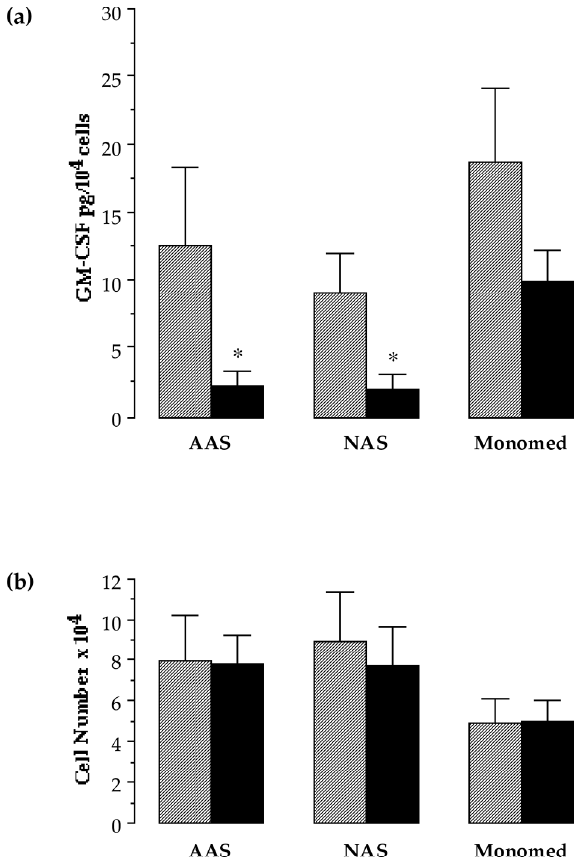
FIG. 1. (a) IL–1 b and TNF- a induced GM-CSF release, and (b) human airway smooth muscle cell (ASMC) density in cultures immediately prior to stimulation with IL–1 b and TNF- a . Confluent human ASMC were pre-incubated with either allergic asthmatic serum (AAS), non-allergic non- asthmatic serum (NAS) or Monomed™ (a defined serum substitute) for 24h. Cells were serum starved for 24h (striped bars) or 72h (black bars) prior to stimulation with IL–1 b and TNF- a (10ng/ml each) for 24h (Table 1: protocol 1). Bars represent means±SEM from five cell donors. * p £ 0.05 com- pared with appropriate Monomed™